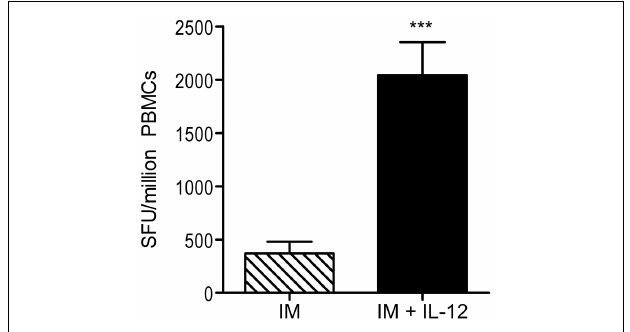
FIGURE 2 | Co-administration of DNA vaccine with plasmid IL-12 increases cellular immune responses . A DNA vaccine encoding HIV-1 consensus immunogens was administered intramuscularly (without EP) to rhesus macaques with or without plasmid-encoded IL-12. Interferon (IFN) gamma ELISpots were performed 2weeks after the third (final) immunization; total antigen-specific cellular responses are shown. n = 5 per group; ***represents p < 0.001. ELISpot, enzyme-linked immunospot assay; HIV-1, human immunodeficiency virus-1; SFU, spot-forming units; IL, interleukin. Modified from Hirao et al.